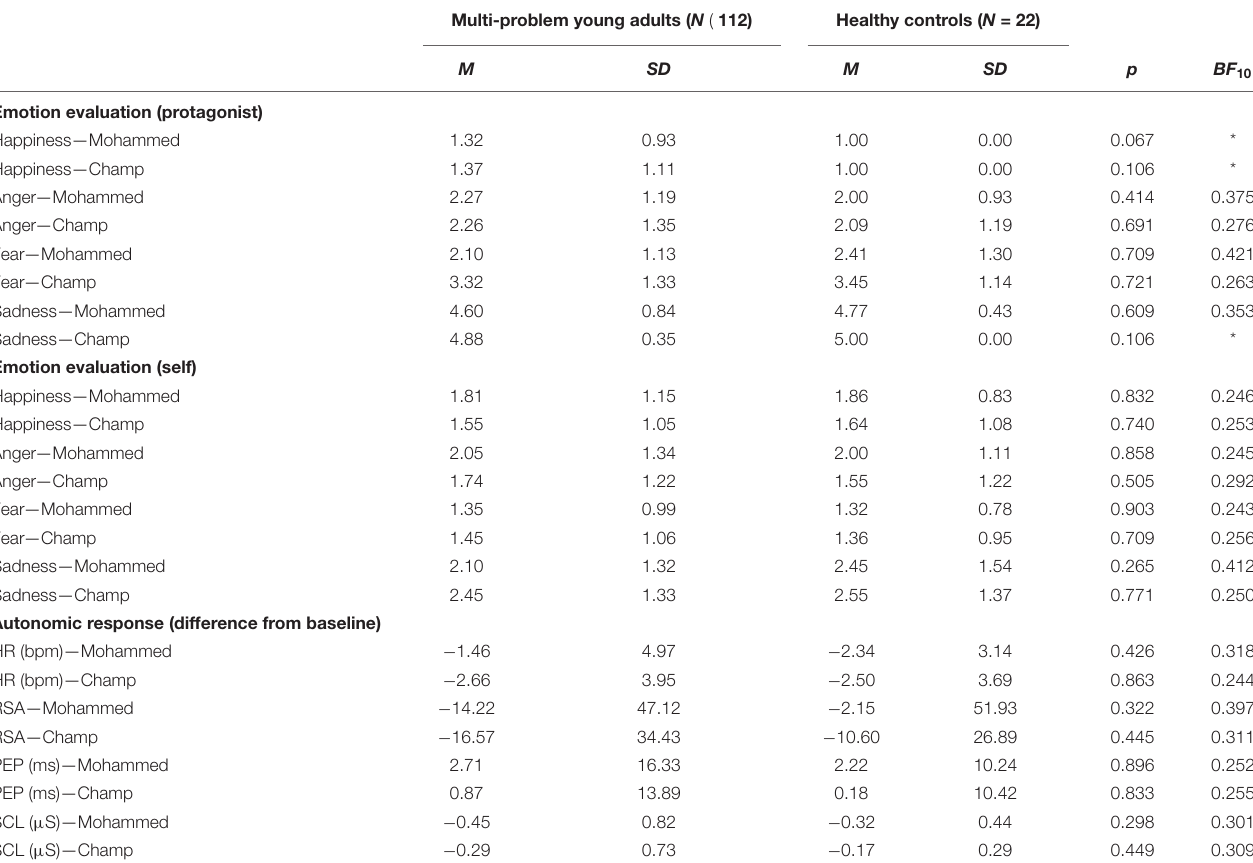
TABLE 5 | Evaluation of emotions and autonomic responses to